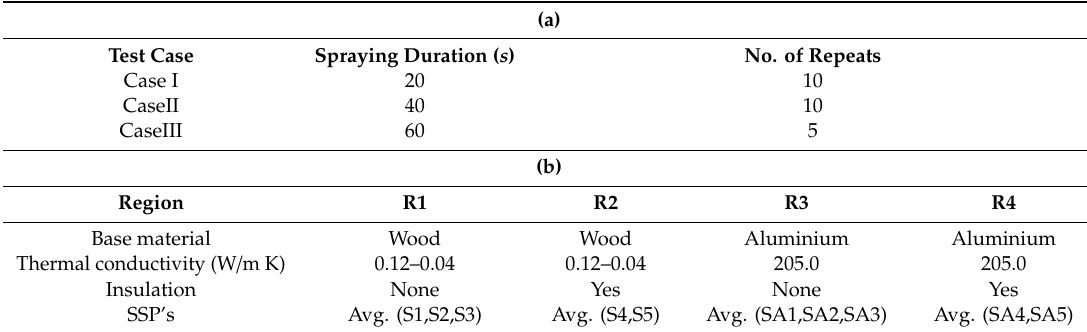
Table 2. ( a ) Icing test cases, ( b ) Division of sensor areas into four distinct